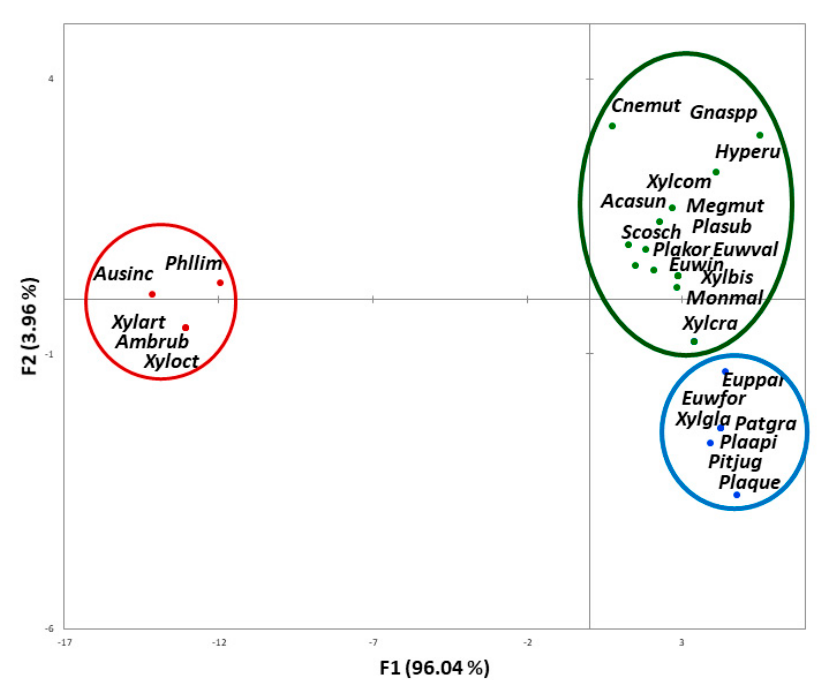
Figure 1. Scatter plot of the two discriminant functions (with percentage of variance explained in parentheses) showing the position of the 26 species and groups of species, and associated categories of damage [red circle far left (no damage), green oval top right (moderate damage), blue circle bottom right (substantial damage)] in the risk factors space. Acasun: Acanthotomicus suncei ; Ambrub: